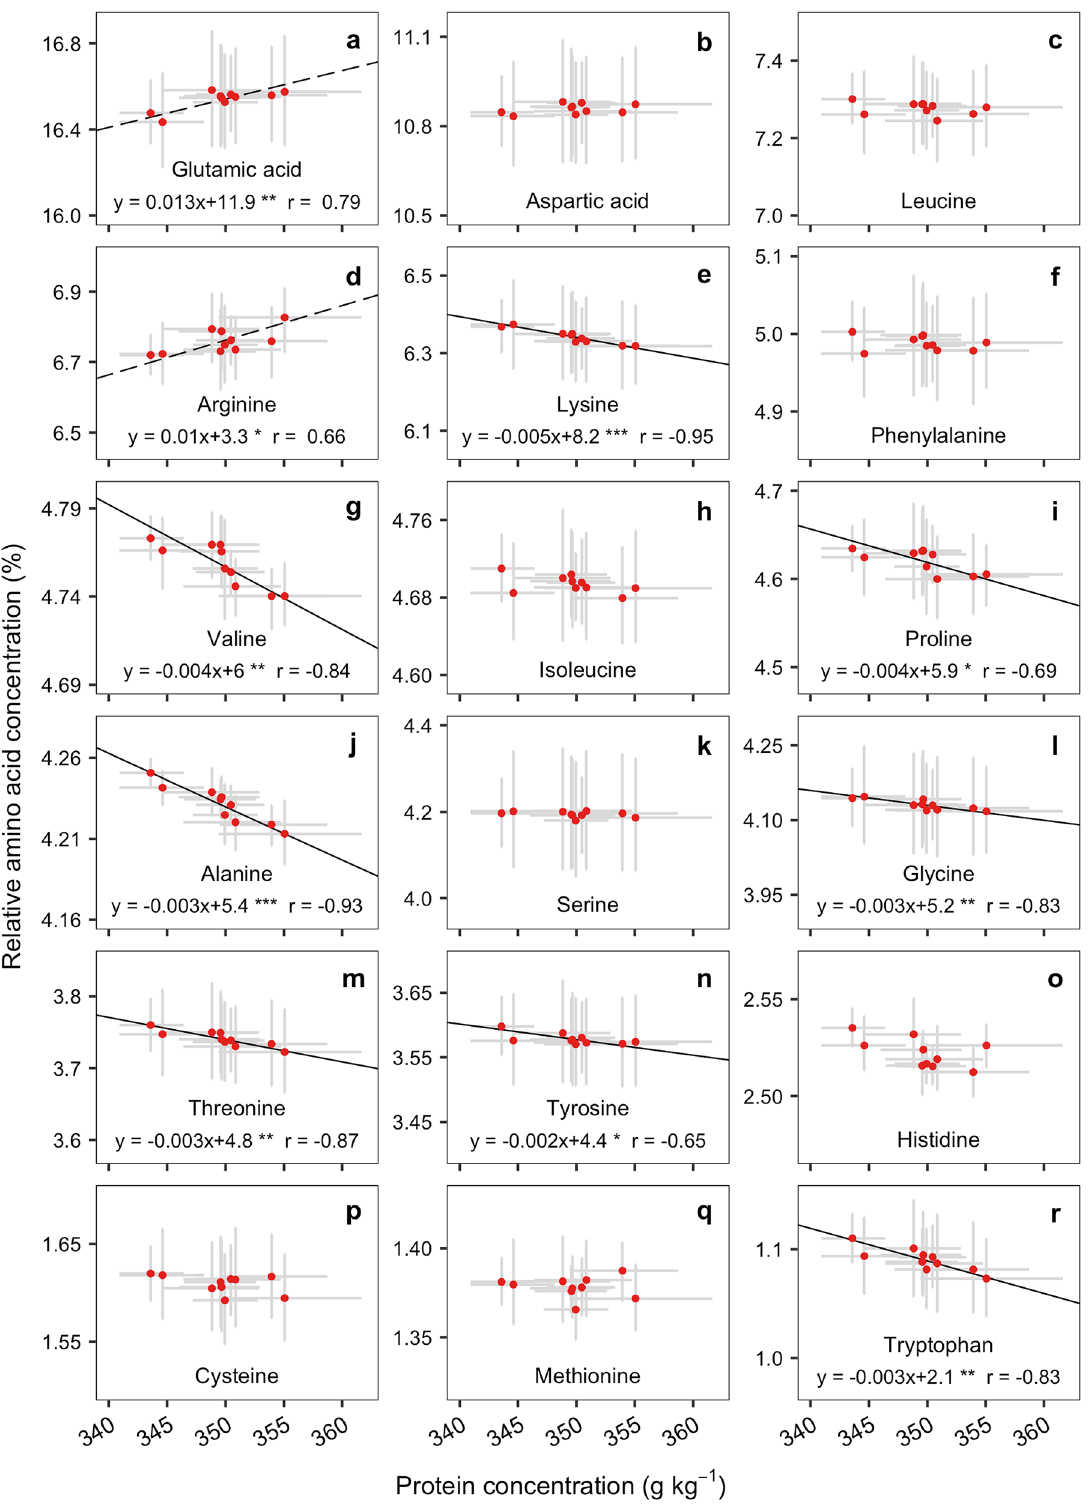
Figure 4. Relationship between glutamic acid ( a ), aspartic acid ( b ), leucine ( c ), arginine ( d ), lysine ( e ), phenylalanine ( f ), valine ( g ), isoleucine ( h ), proline ( i ), alanine ( j ), serine ( k ), glycine ( l ), threonine ( m ), tyrosine ( n ), histidine ( o ), cysteine ( p ), methionine ( q ), tryptophan ( r ), and protein concentration in seed of genotypes released from 1980 to 2014. Each point represents the average amino acid concentration between the two N treatments and genotypes (if more than one per year). Solid black line indicates the fitted model when the slope is negative, whereas dashed line indicates models with positive slope ( P < 0.05) . Asterisks indicate significance of the coefficient: *** P < 0.001; ** P < 0.01; * P < 0.05. The r value represents the Pearson correlation